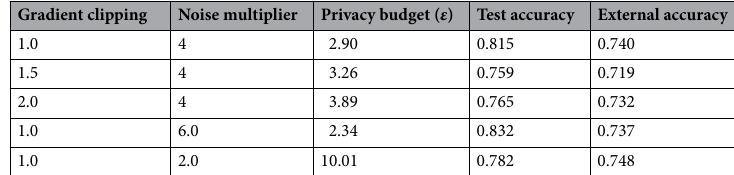
Table 2. For each of the four clients, we divided their available images in an 80:20 ratio for training and internal testing datasets, respectively. Then we combined the images from the remaining three hospitals into a single